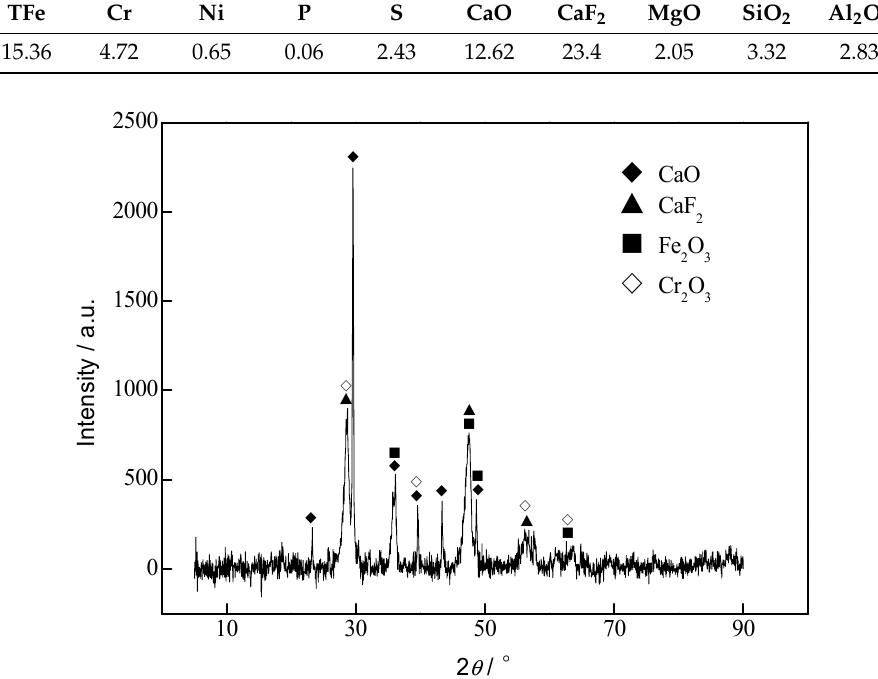
Figure 1. XRD pattern of pickling sludge after drying at 105 °C.